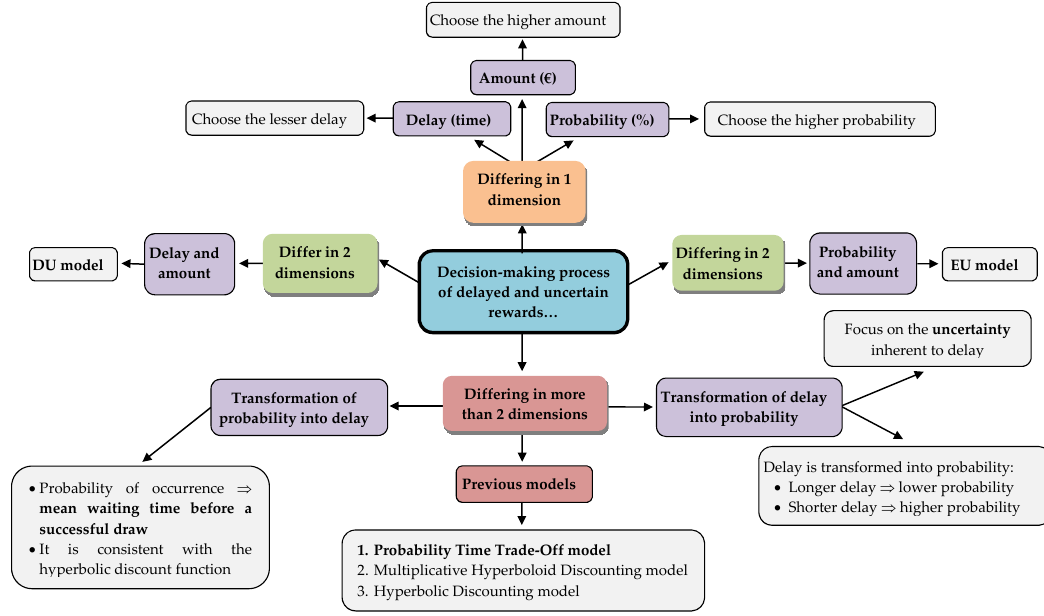
Figure 1. Decision-making process of delayed and uncertain rewards. Source: Own